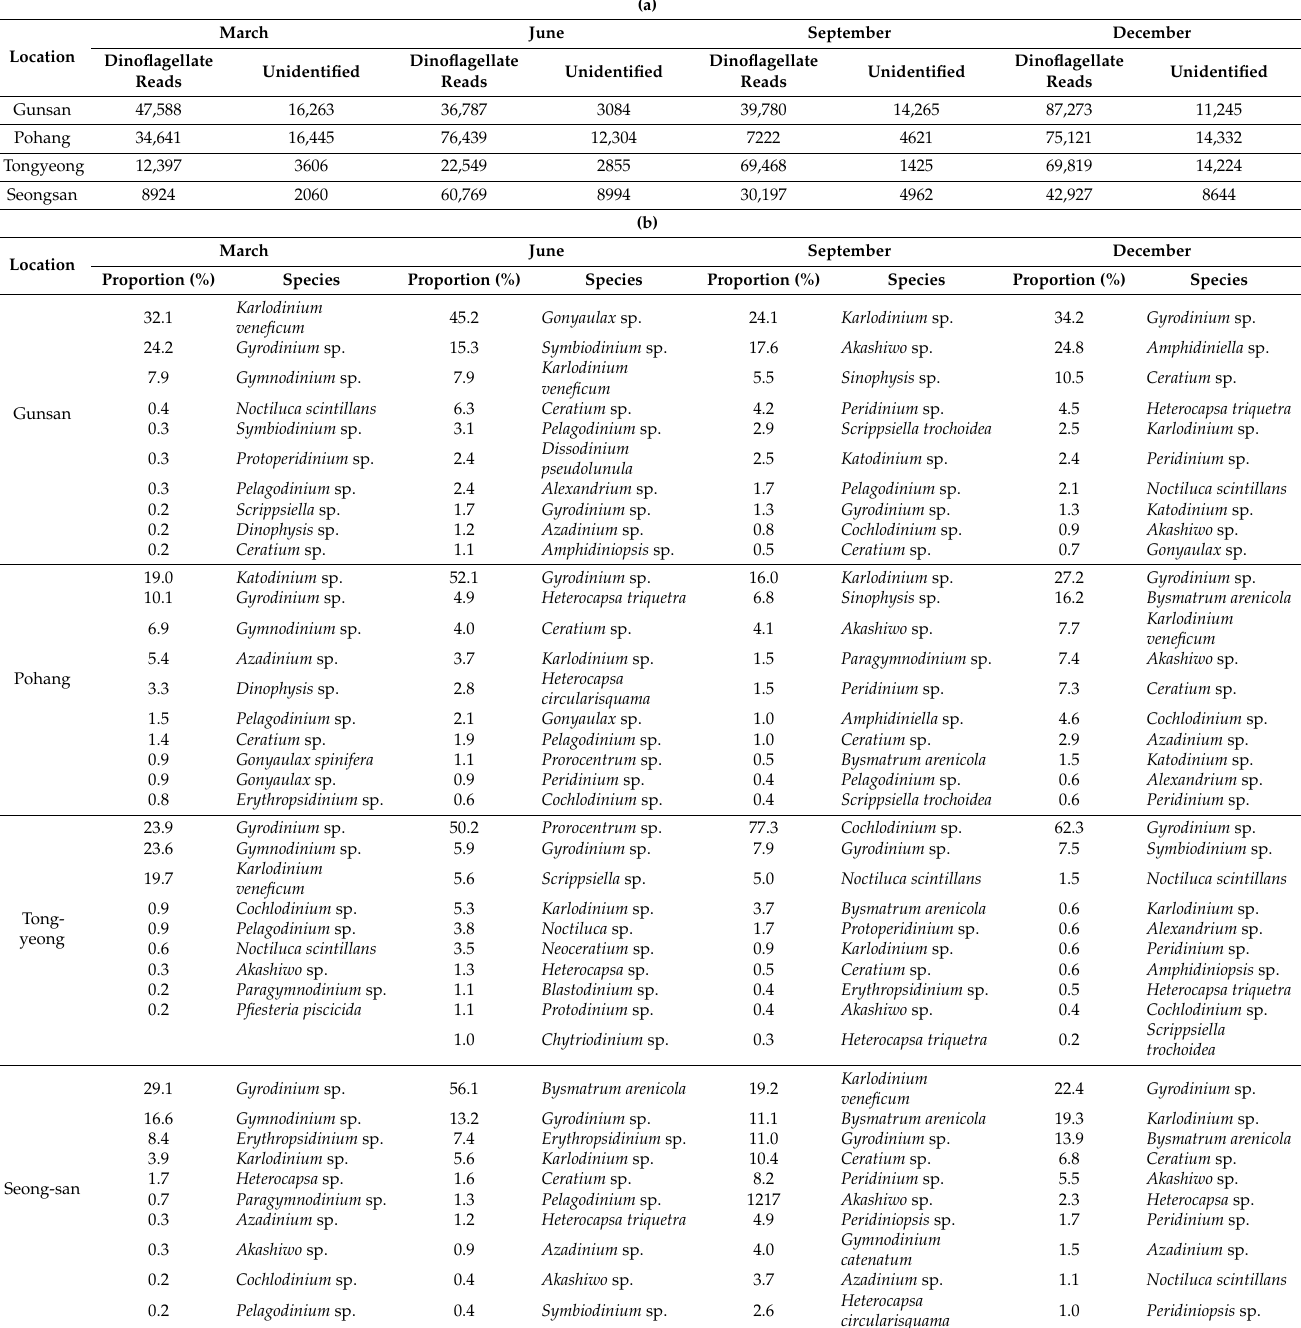
Table 1. Seasonal variations and distribution of dinoflagellates in four coastal waters (Gunsan, Pohang, Tongyeong, and Seongsan) by metagenomic analysis. Total dinoflagellate reads and uniden- tified reads ( a ), and proportion(%) of the 10 most common dinoflagellate species ( b ).